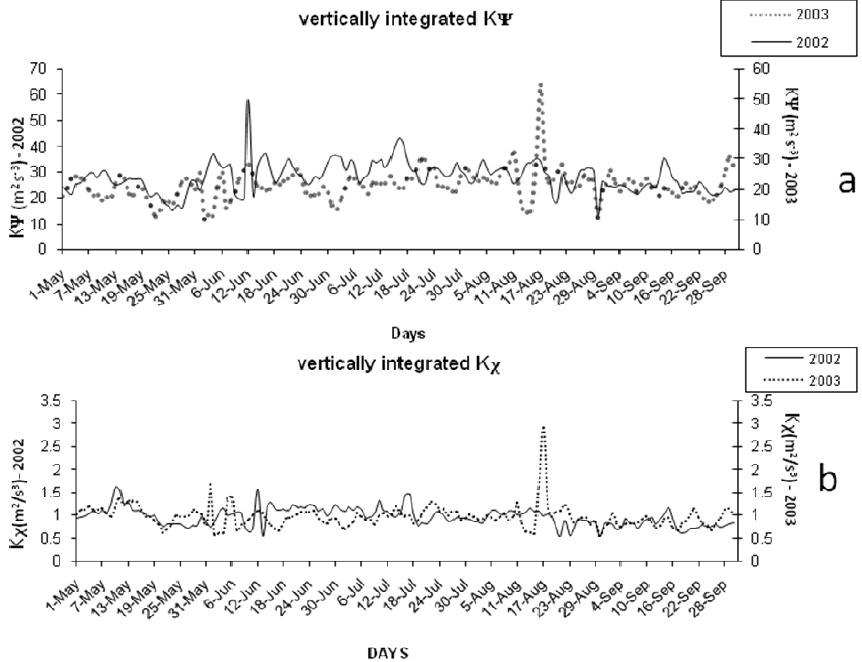
Fig. 7. Variation of Vertically Integrated (1000–100hPa) kinetic ( K 9 and Kχ) energy from 1 May–30 September during 2002 and 2003 for the domain 30 ◦ S–40 ◦ N and 30 ◦ E–150 ◦ E shown in panels (a) , (b) , respectively.